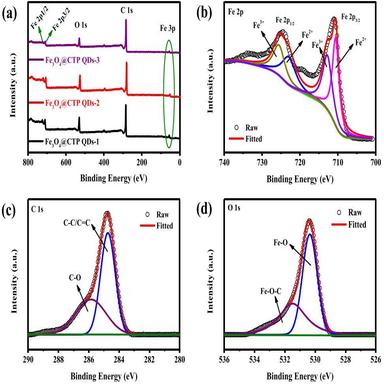
FT-IR spectra of CTP QDs and Fe3O4@CTP QDs-2 composite.